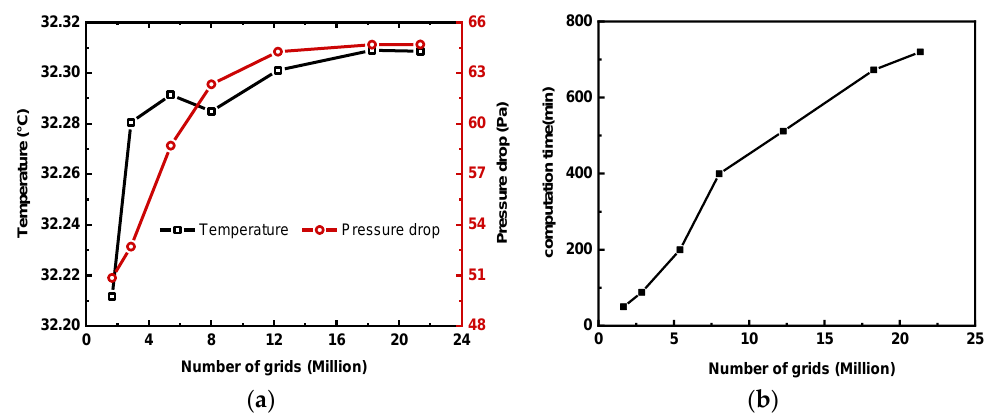
Figure 2. Results of grid independence verification for the BTMS simulation model. ( a ) The variation of center point temperature of battery 1 and pressure drop through the channel with the number of grids; ( b ) the variation of computation time with the number of grids.